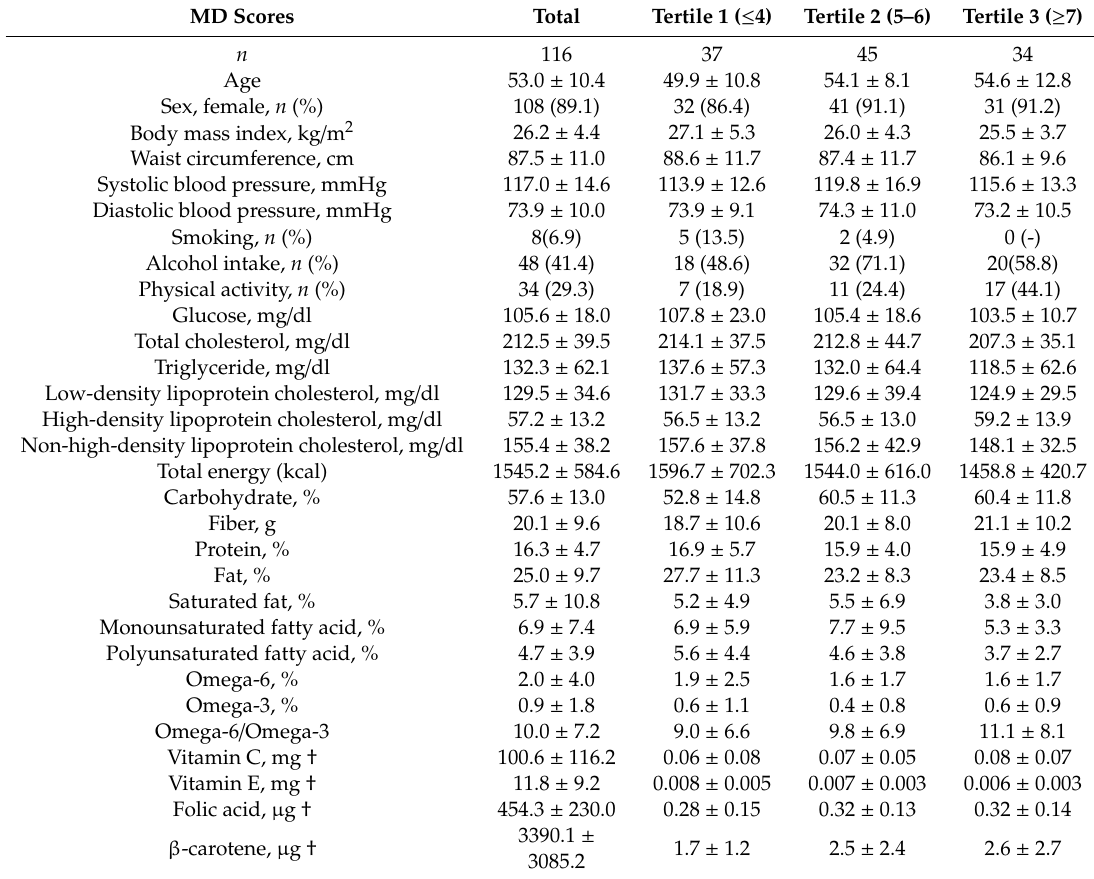
Table A1. Clinical characteristic of high-risk group according to the MD score